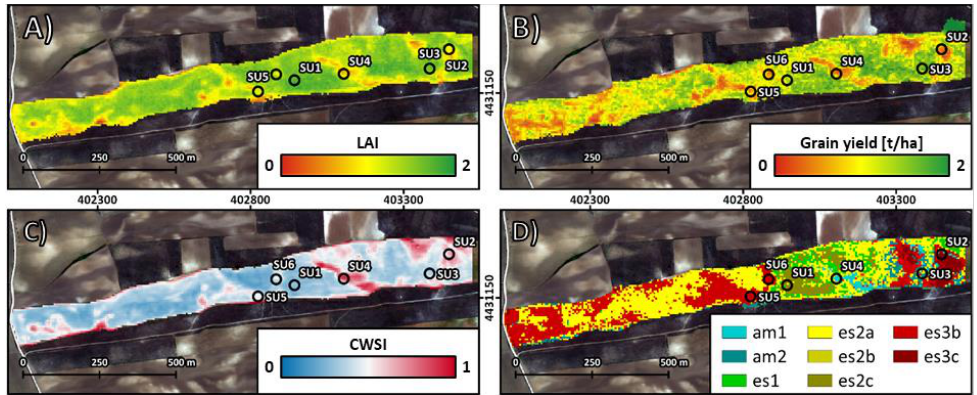
Figure 9. Field plot SU: Spatial distribution of estimated ( A ) LAI and ( B ) Grain yield; ( C ) CWSI compared with ( D ) Bare soil classification of SEAS of Schmid et al. (2015).